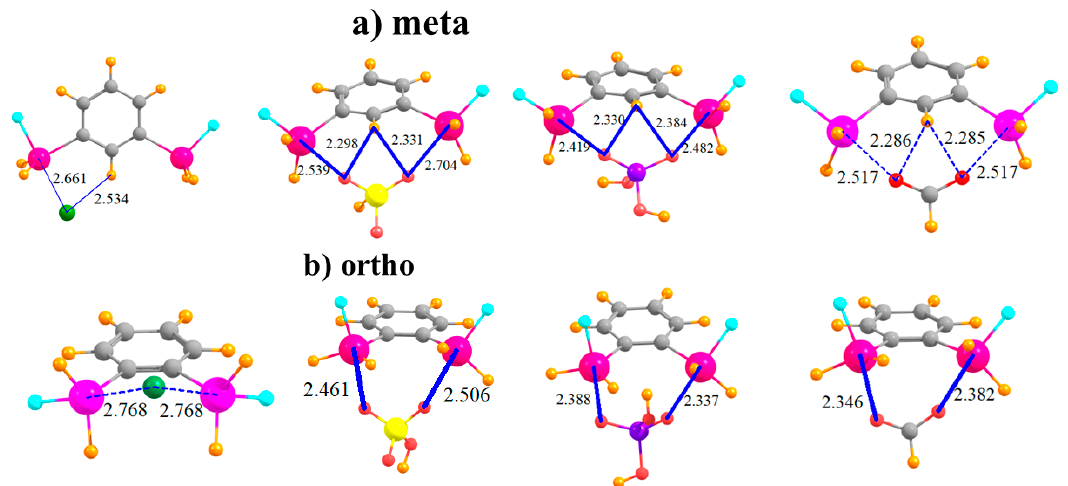
Figure 3. Complexes of Cl − , HSO 4 − , H 2 PO 4 − , and HCOO − with ( a ) meta and ( b ) ortho disubstituted phenyl rings. 168